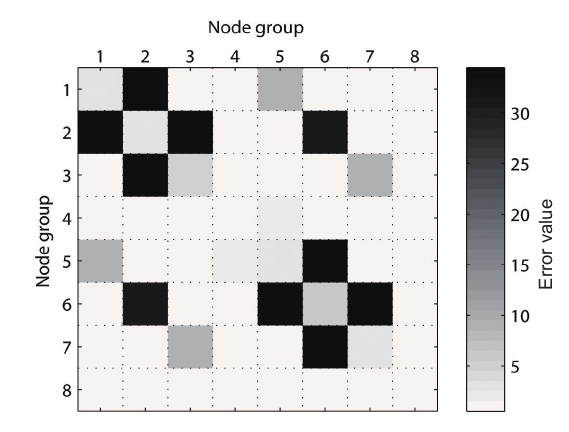
Figure 12. Error metric based on the grouped nodes.